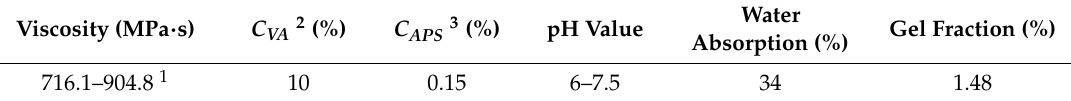
Table 3. The basic parameters of the PVAc solution.